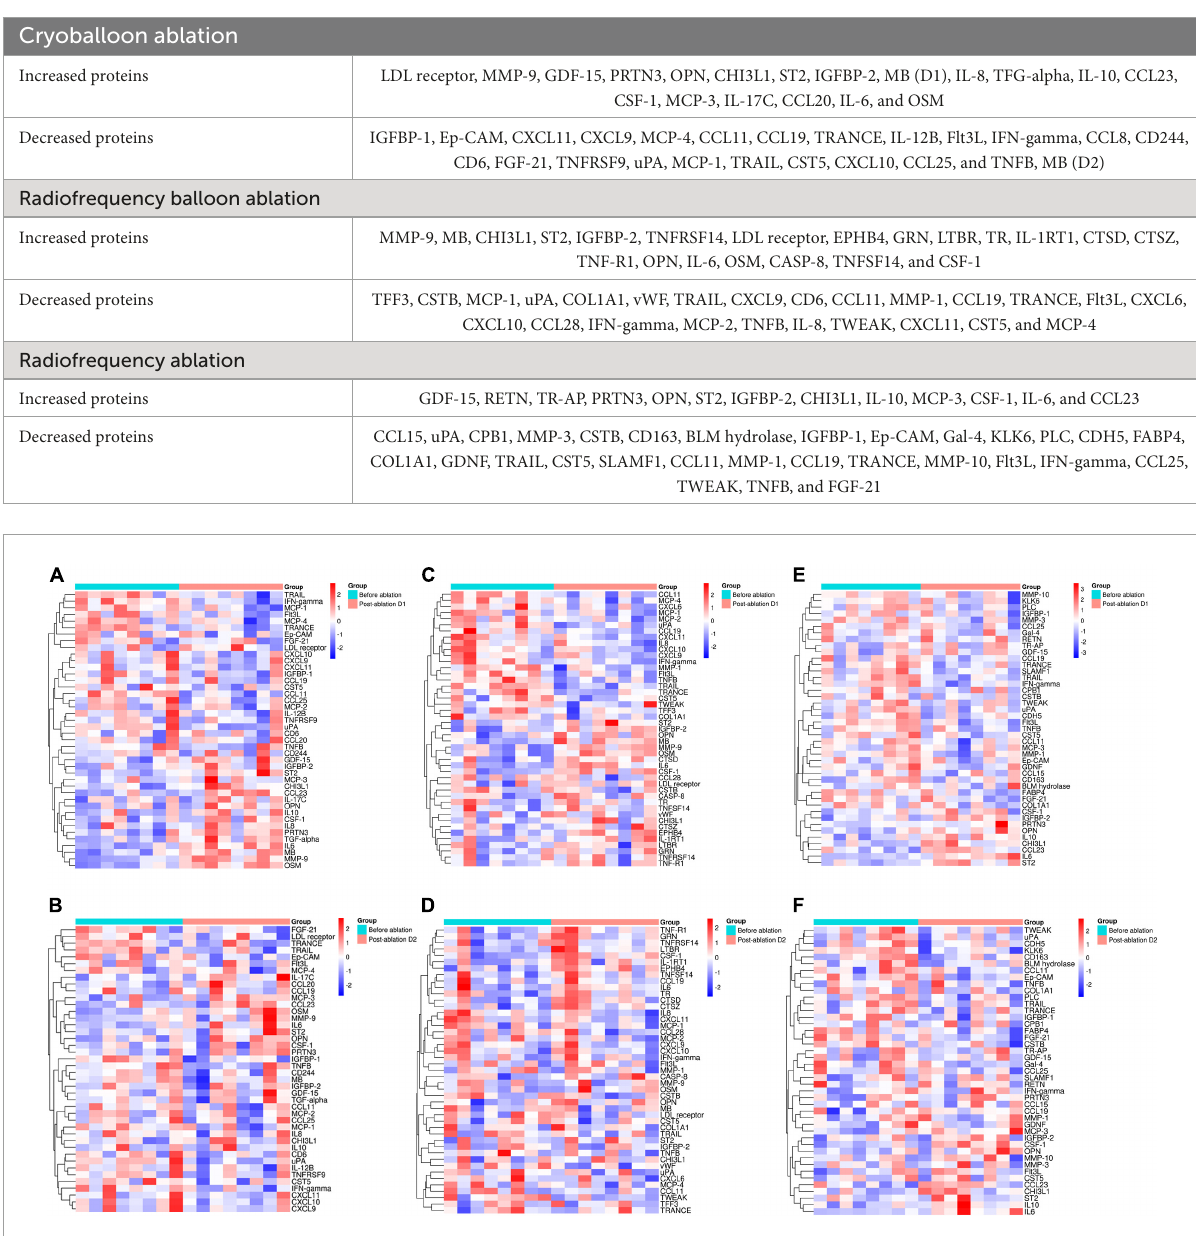
protein in the protein–protein interaction (PPI) network (degree cutoff = 2, node cutoff = 0.2, k-core = 2, and